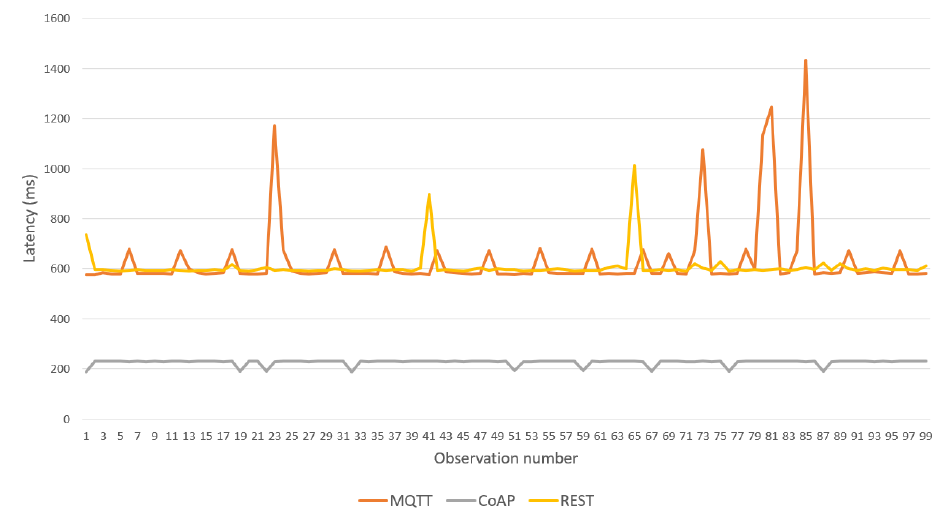
Figure 14. Latencies of the binding protocols over Wi-Fi (for IoMT devices<->Fog Server). Table 2. Maximum and average latencies for each BP.